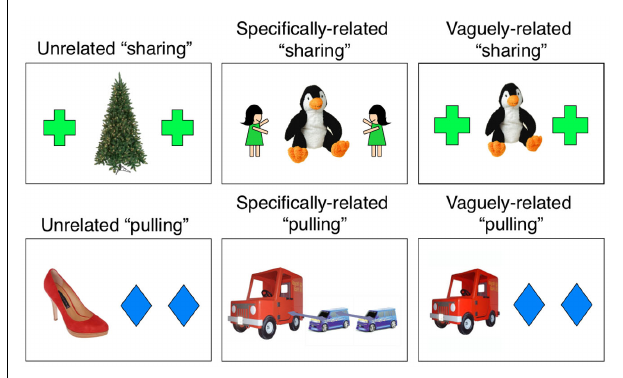
FIGURE 3 |Training cards for Experiment